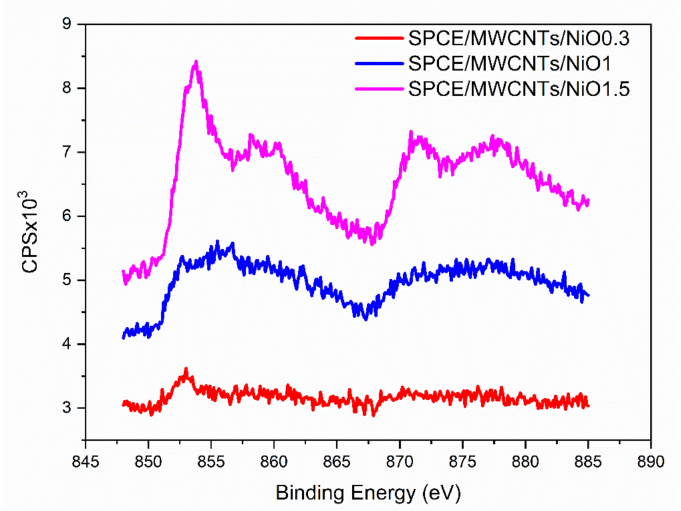
Figure 5. XPS spectra for the modified electrodes: SPCE/MWCNT/NiO0.3 (red curve), SPCE/ MWCNT/NiO1 (blue curve), and SPCE/MWCNT/NiO1.5 (pink